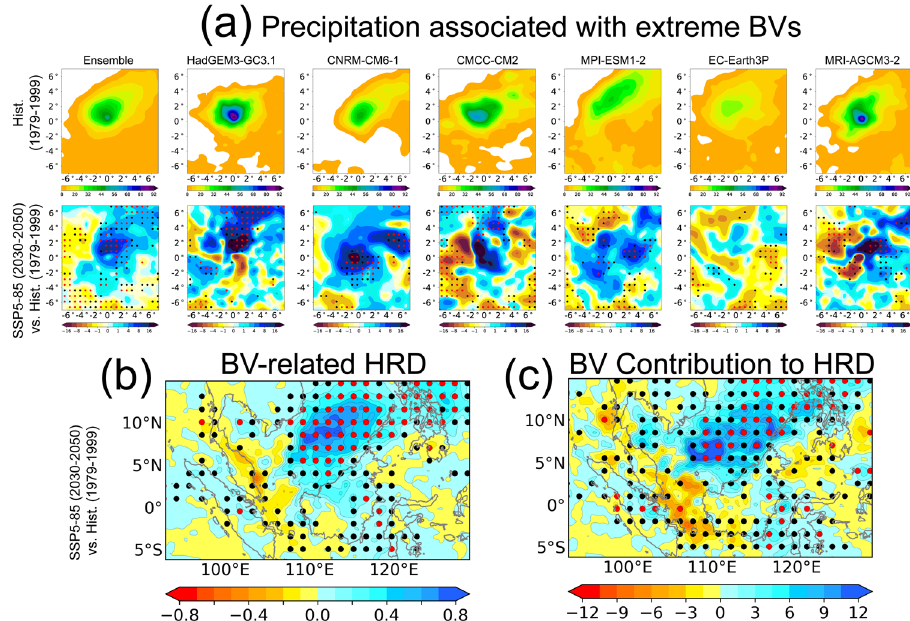
Fig. 3 Changes to BV-associated extreme precipitation. a Center-relative composites of precipitation intensity (in the time steps corresponding to the highest central relative vorticity at 850-hPa during the lifetime; unit: mm per day) averaged over 50 most intense BVs simulated by each multi-GCM ensemble member for the historical period (1979 – 1999, upper row) and the projected absolute changes under SSP5-85 (2030 – 2050, lower row). b Ensemble mean of the projected absolute changes in BV-related heavy rain days (HRDs, unit: days per season) during ONDJFM. c Ensemble mean of the projected absolute changes in the fractional contribution (%) of BVs to the total HRDs during ONDJFM. Stippling indicates statistical signi fi cance at the con fi dence levels of above 90% (black) and 95%